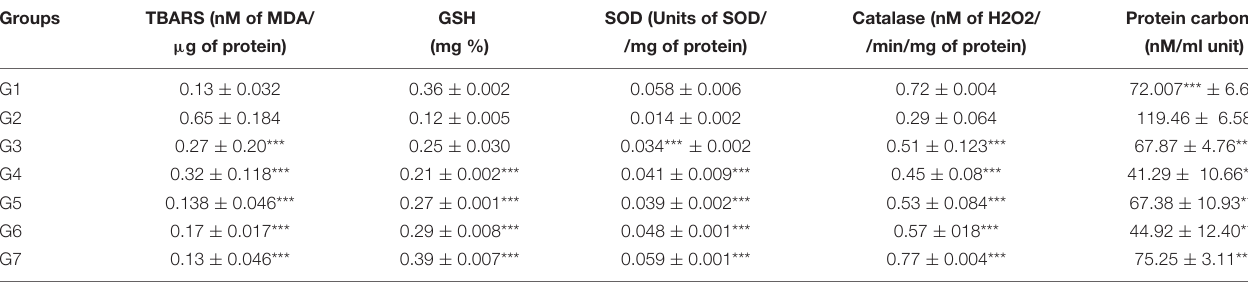
TABLE 2 | Effect of VOA/VIN on oxidative stress markers. Groups TBARS (nM of MDA/ GSH SOD (Units of SOD/ Catalase (nM of H2O2/ Protein carbonyl µ g of